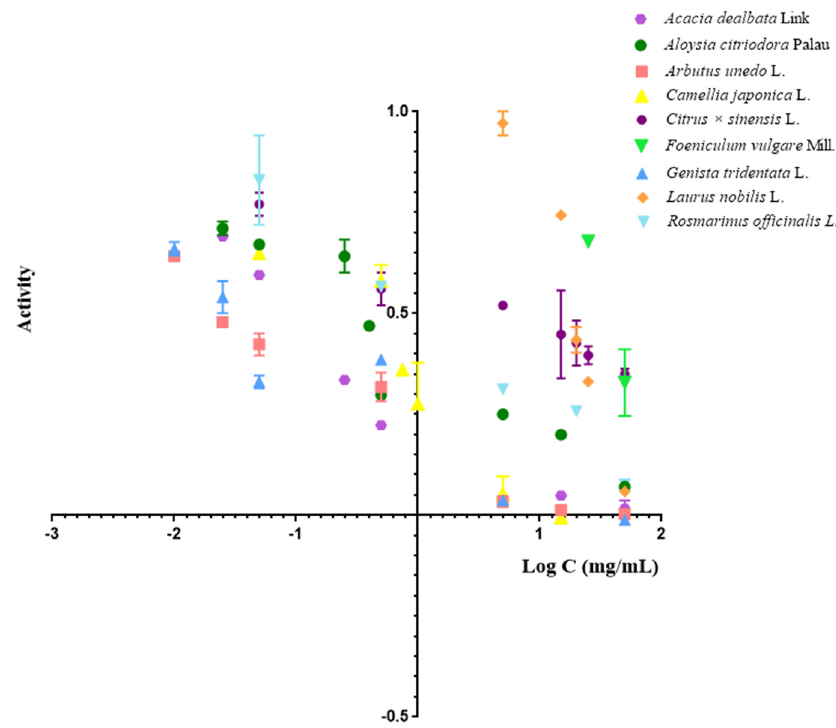
Figure 2. Inhibition profiles of plant extracts in MPO assays in SIA. The IC 50 values described represent inhibitor concentrations that induce a 50% inhibi- tion of MPO activity and were obtained from the analysis of inhibition curves in sigmoid form. Therefore, the lower the IC 50 value, the lower the inhibitor concentration needed to inhibit 50% of the enzyme; therefore, this is more toxic for MPO. Increased MPO concentration during inflammatory processes is related with the in- creased formation of reactive oxygen species and reactive nitrogen species during oxidative stress. The produced species are related to the oxidative explosion of neutrophils associated with tissue damage, which sustains the failures and anomalies that occur during inflamma- tion. The phenols present in plant extracts have hydroxyl groups (-OH) in their structure, which are good hydrogen donors. These groups (-OH) can bind to the active site of the enzyme (preventing the binding with the substrate) and preventing the for- mation of the product, thus providing a competitive and reversible inhibition. When this happens, the ROS and RNS generation cycle will be interrupted through inhibition of the MPO enzyme. The antioxidant and anti-inflammatory potential of phenols is related to the presence of OH structures in their composition [16–18,41–43]. By critically analyzing the results in Table 1, it is possible to compare the different extracts. Regarding the extracts derived from Foeniculum vulgare Mill. and Arbutus unedo L., we realize that they are the ones with the highest and lowest IC 50 , and are accordingly the least and most toxic for MPO, respectively. Although no clear justification was previ- ously studied, we can start from some studies that were previously carried out with these plants and draw some conclusions. If we check the phenolic composition of the species Foeniculum vulgare Mill., we can see that it is essentially constituted by phenolic acids, mainly chlorogenic, caffeic and rosmarinic acid, and by some flavonoids, mainly querce- tin, rutin and apigenin [44–46]. However, the flavonoids are present in lower concentra- tions, and there are few subclasses of them. On the other hand, if we evaluate the species Arbutus unedo L., mostly flavonoids such as quercetin, anthocyanins (cyanidin and del- phinidin glycosides), among others, are identified. In addition to these, hydroxybenzoic acids such as gallic acid were the main phenolic compounds reported and, in minor con- centrations, chlorogenic acid was also found [47–49]. Flavonoids are able to modulate